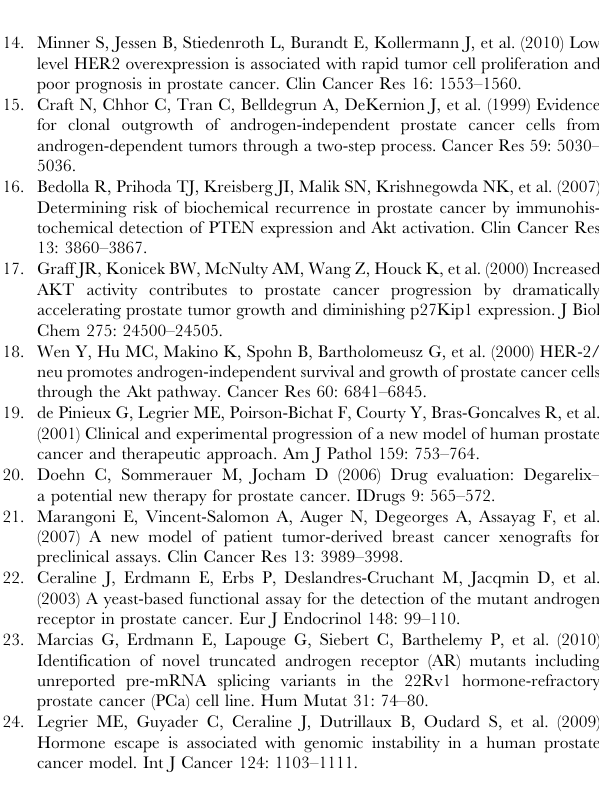
Figure S2 Relative mRNA expression of androgen re- ceptor (AR) (black bars) and intratumoral prostate- specific antigen (PSA) (white bars) in androgen in- dependent (AI) variants. *indicates variants with amplified AR gene copy number. Abbreviations used to identify variants are explained in the legend of Figure 2. Figure S3 Hormone response profile in the AIde-a4 castration-resistant tumor. The responsiveness of the AR in the AIde-a4 castration-resistant tumor was assessed by using the yeast-based functional assay and compared with that of the wild- type AR as described in Material and Methods. Histograms represent aberrant responses obtained with 100 nM b -estradiol (E2) and 1 m M cyproterone acetate (CPA) when compared with the wild-type AR. Figure S4 Constitutive activity of Q693X androgen receptor variant. The nonsense mutation Q693X leads to a truncated androgen receptor variant, which is deleted of the entire ligand-binding domain and AF-2. When compared to the ligand-dependent activity of the wild-type AR, the Q693X AR variant demonstrated constitutive activity in the yeast-based AR assay. Histograms represent the relative number of colonies obtained in the presence of the indicated hormone or anti- androgen to that obtained in the presence of 100 nM DHT. DHT, dihydrotestosterone; And, androstenedione; Prog, progesterone; Bic, bicaluta- mide; Flut, flutamide. Table S1 Number of mice assigned to each treatment group.